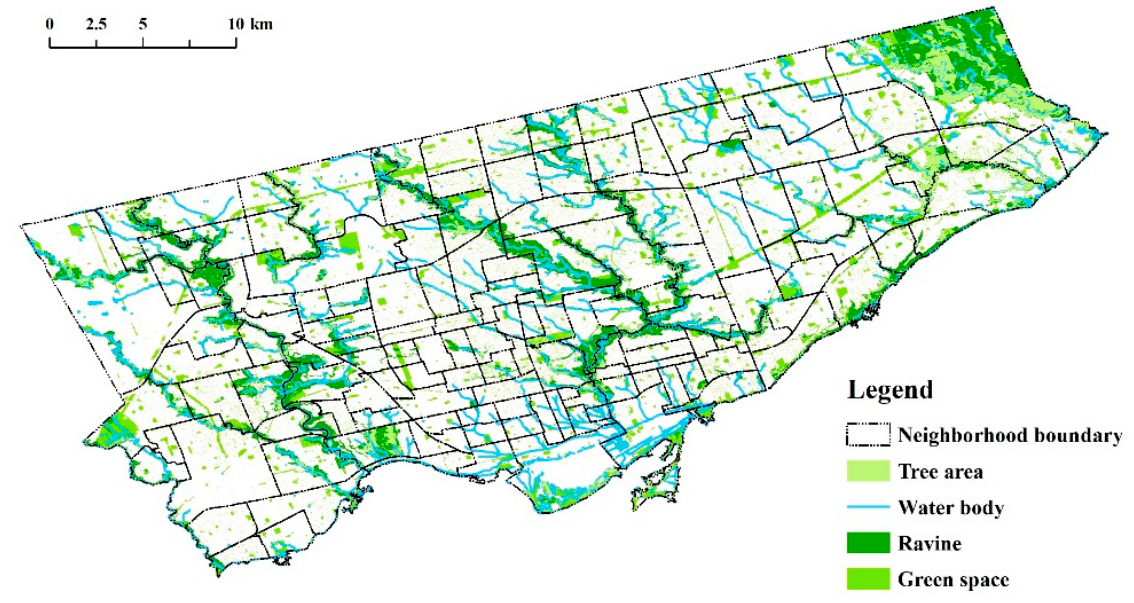
Figure 1. Study area (source: Toronto Open Data).